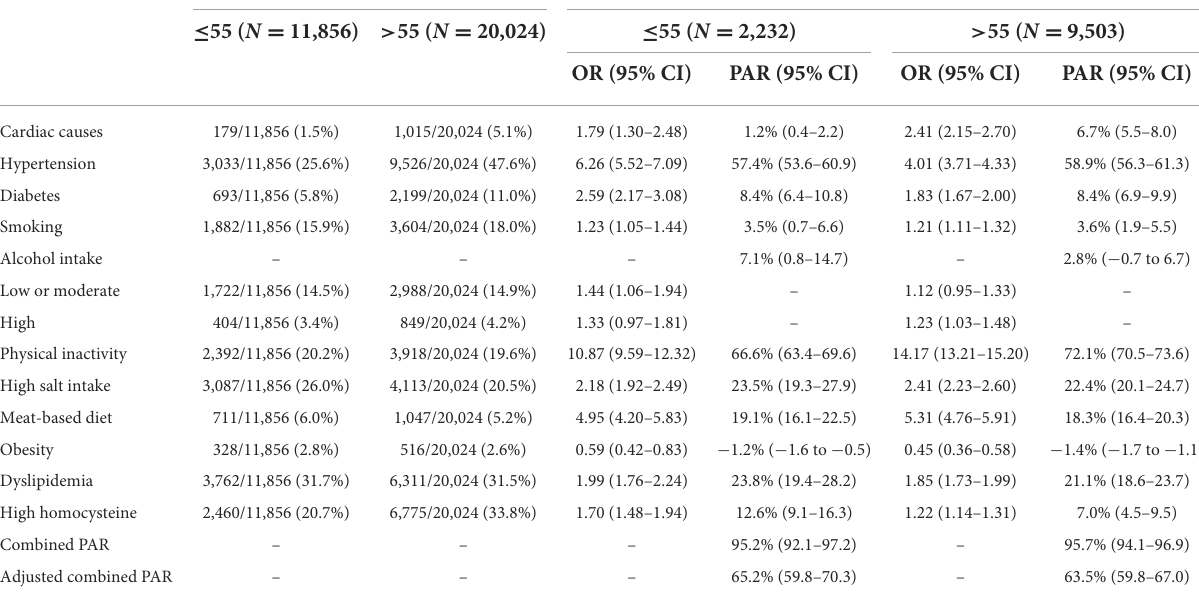
TABLE 2 Risk factors for all stroke by age